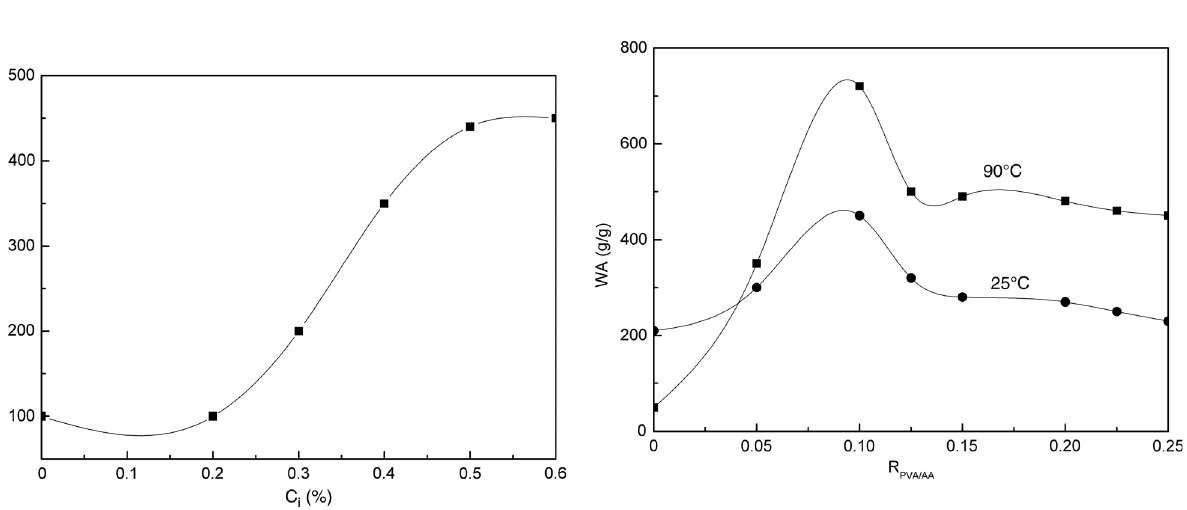
Figure 2 Effect of initiator content on WA.